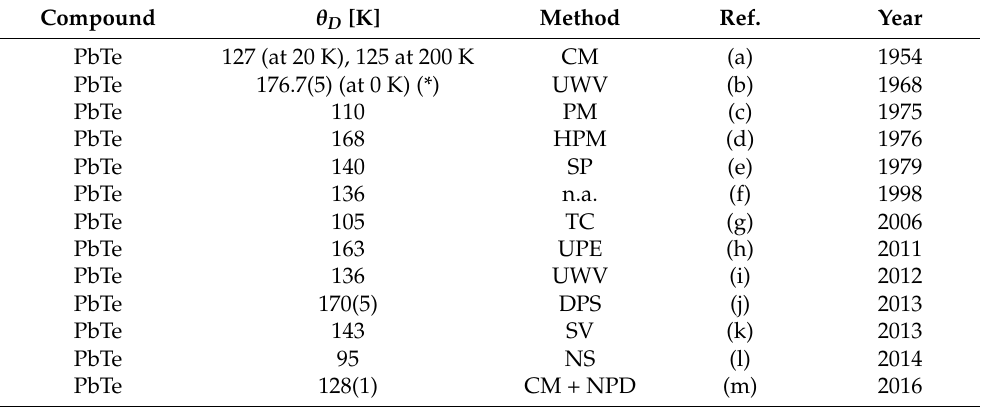
Table 12. Experimental Debye temperature, θ D , determined by non-diffraction methods for PbTe.